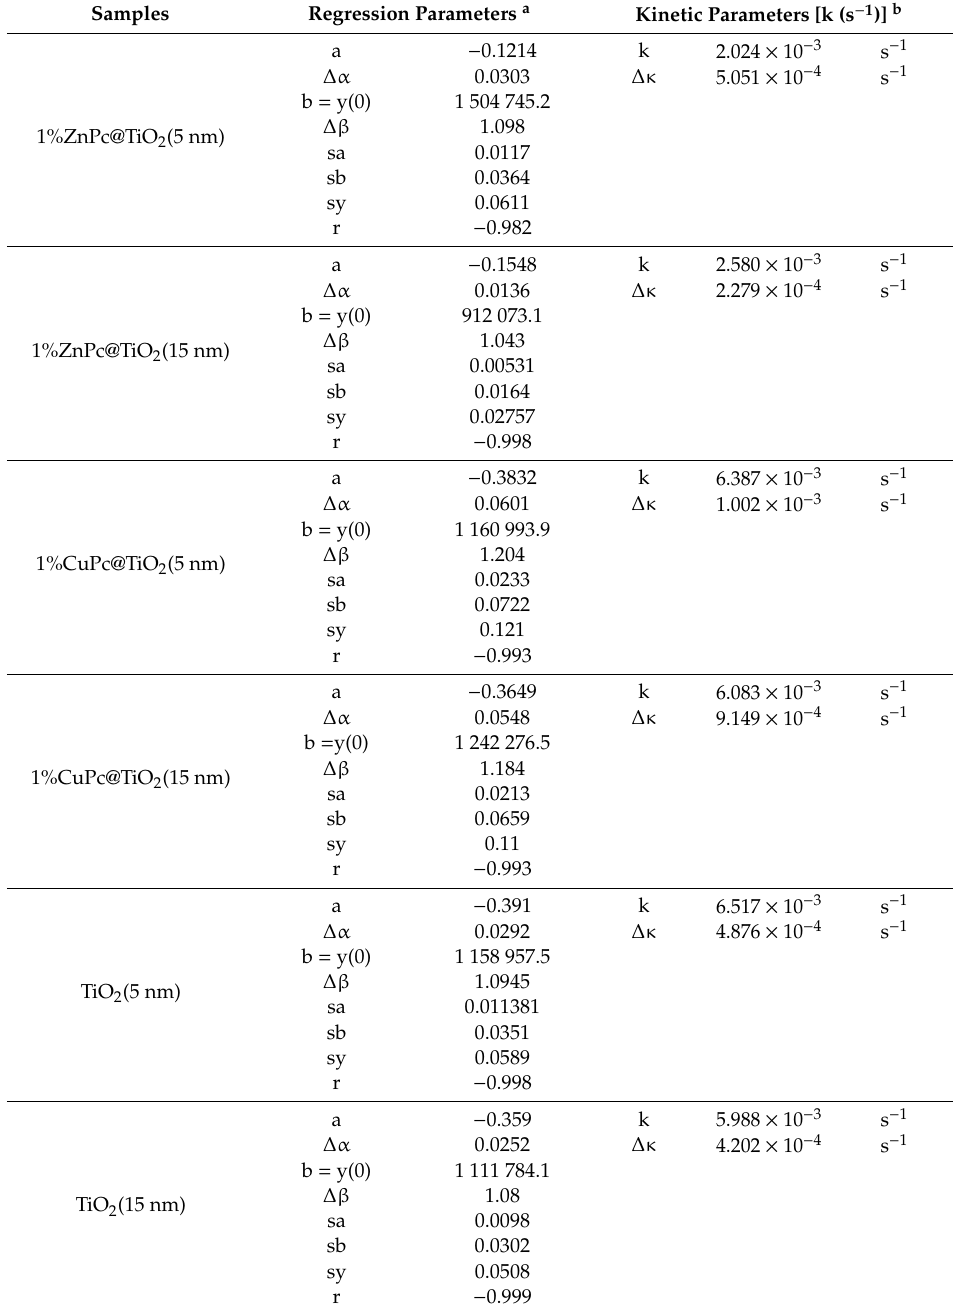
Table 4. The regression and kinetic parameters of IBU degradation rate constants (k, s − 1 ) under